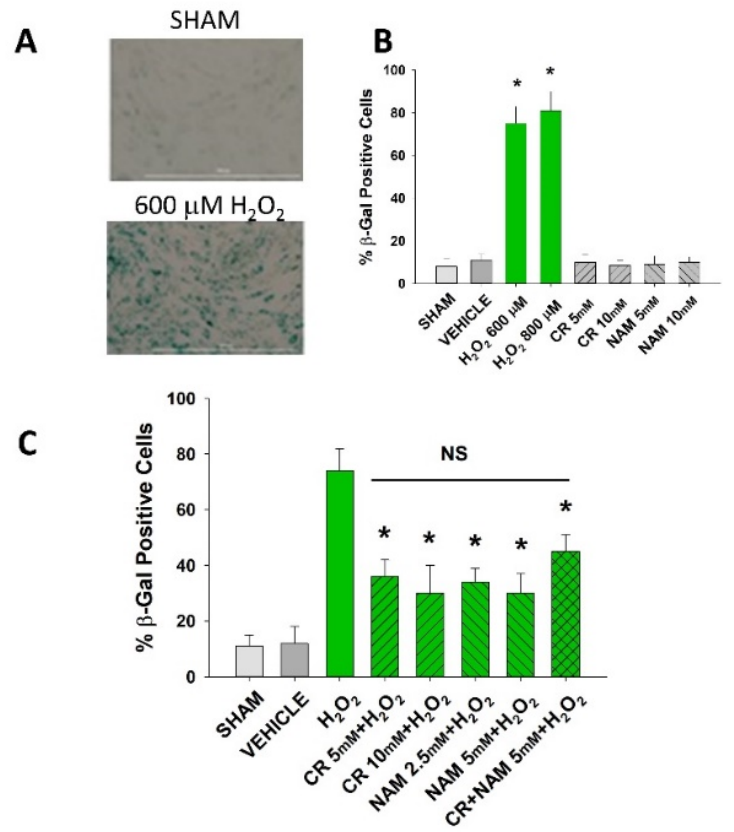
Figure 2. Effect of Cr and NAM pretreatment on oxidant-induced β -gal activity. DHF were exposed to various concentrations of Cr or NAM alone or combined (5 mM each), media alone (SHAM), or water vehicle (1%). Twenty-four hours later, the cells were exposed to 600 µ M H 2 O 2 for 2 h, followed by replacement with treatment and harvesting 72 h later for β -gal staining. ( A ) representative pictures of β -gal staining of vehicle versus H 2 O 2 treatment, indicating increased staining (senescence) due to oxidant exposure; ( B , C ) % β -gal positive cells in response to various treatments. The data are mean ± SE from 3–4 separate experiments using duplicate samples. * Denotes statistically significant changes in the Cr/NAM treated levels in comparison to H 2 O 2 alone. NS, the treatments compared to one another are not statistically significantly different.